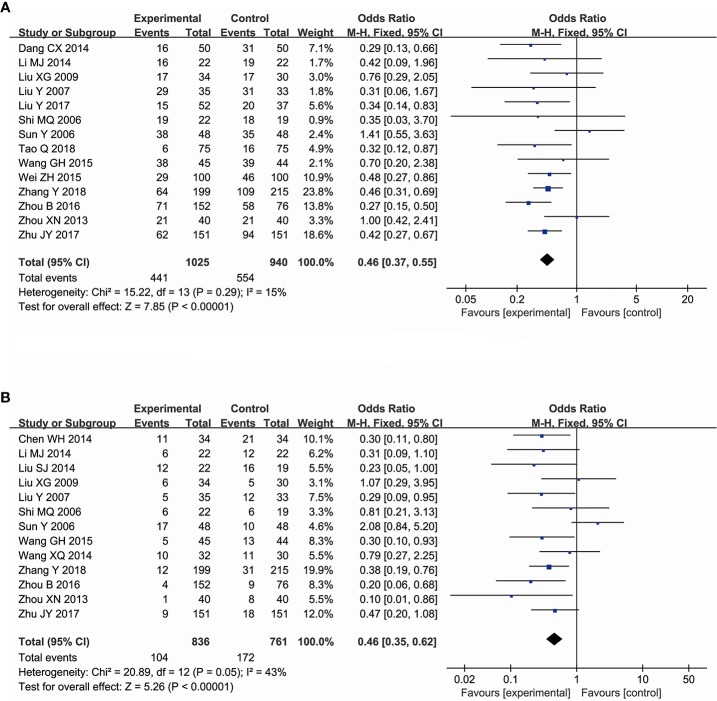
Forest plot for the decline of leukocyte counts. (A) The decline of leukocyte counts I–IV. (B) The decline of leukocyte counts III–IV.